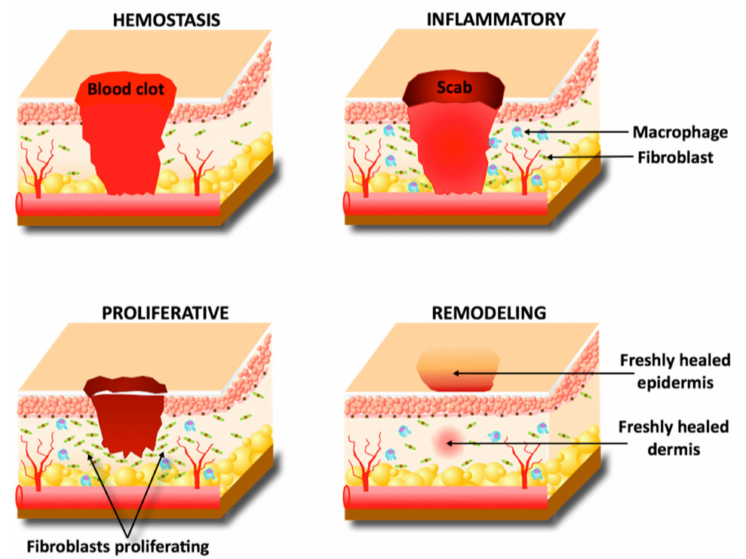
Figure 1. Wound self-healing